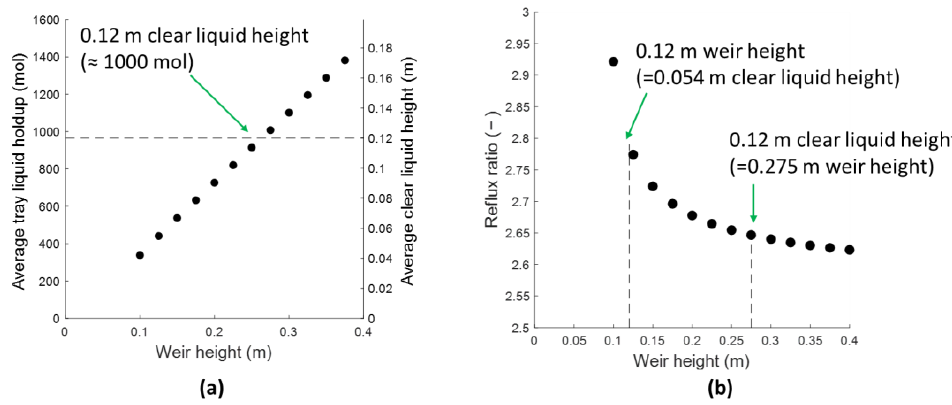
Figure 3. Average liquid holdup and corresponding average clear liquid height ( a ) and reflux ratio ( b ) as function of the weir height to obtain 95% top and bottom purities of C and D using sieve trays for Luyben’s column. AG/An = 0.10, each downcomer area = 10% of column cross section.